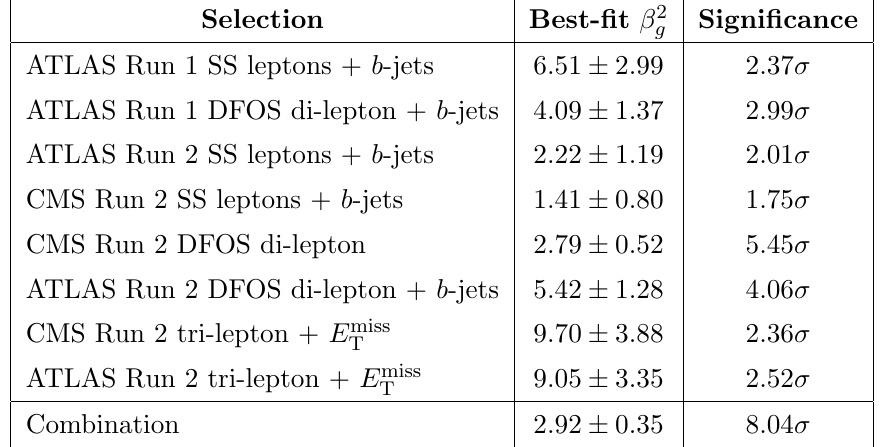
Table 2 . A summary of the SM+BSM (cid:12)t results for each measurement considered in this article, along with the result of their